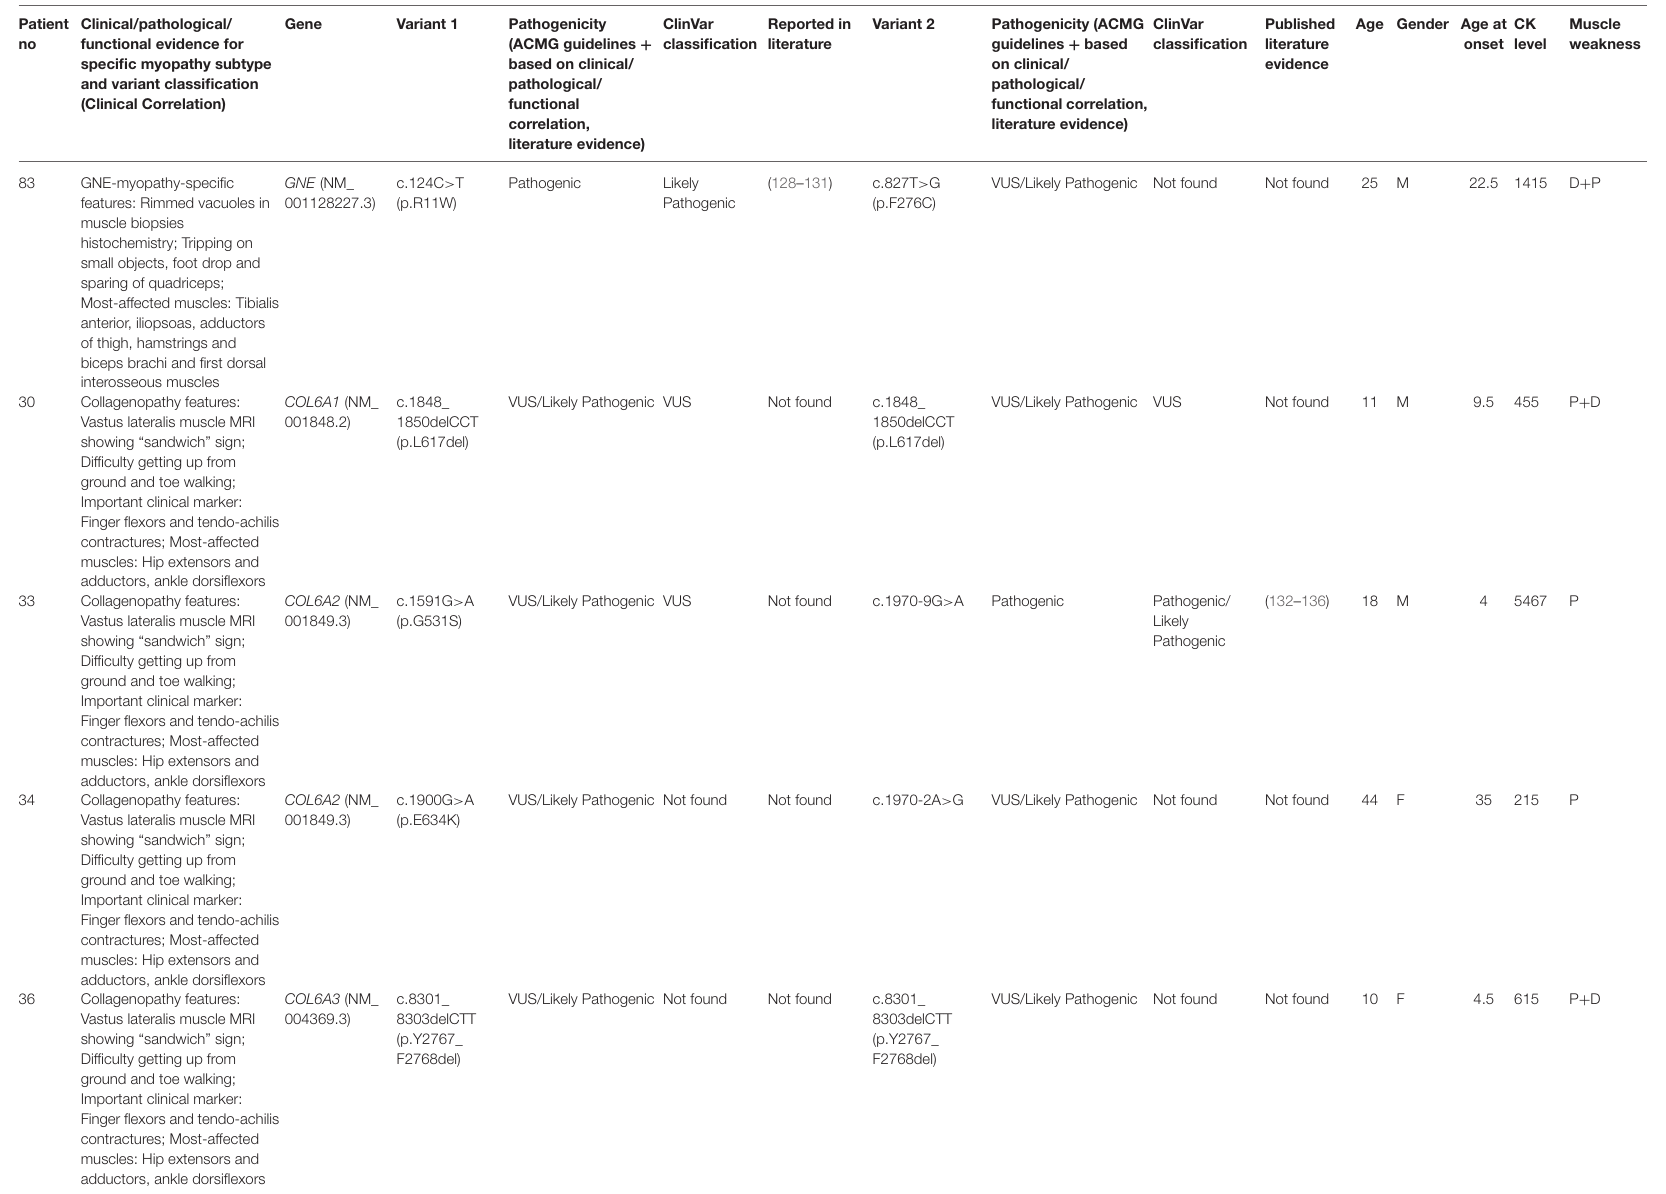
Collagenopathy features: Vastus lateralis muscle MRI showing “sandwich” sign; Difficulty getting up from ground and toe walking; Important clinical